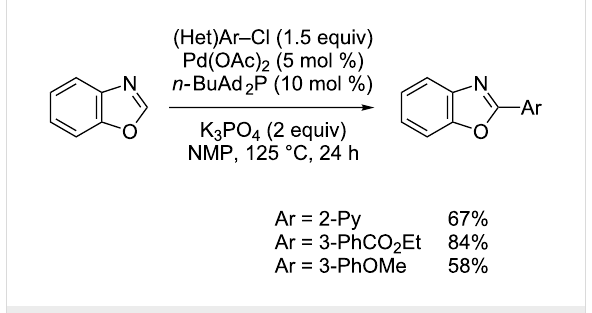
(phenyloxazolephenyloxazolephenyl) references, and with high